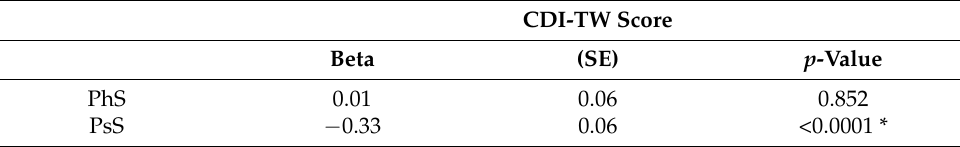
Table 5. Multivariant analysis for the relationship between physical summary score, and psychosocial summary score in Child Health Questionnaire—Parent Form